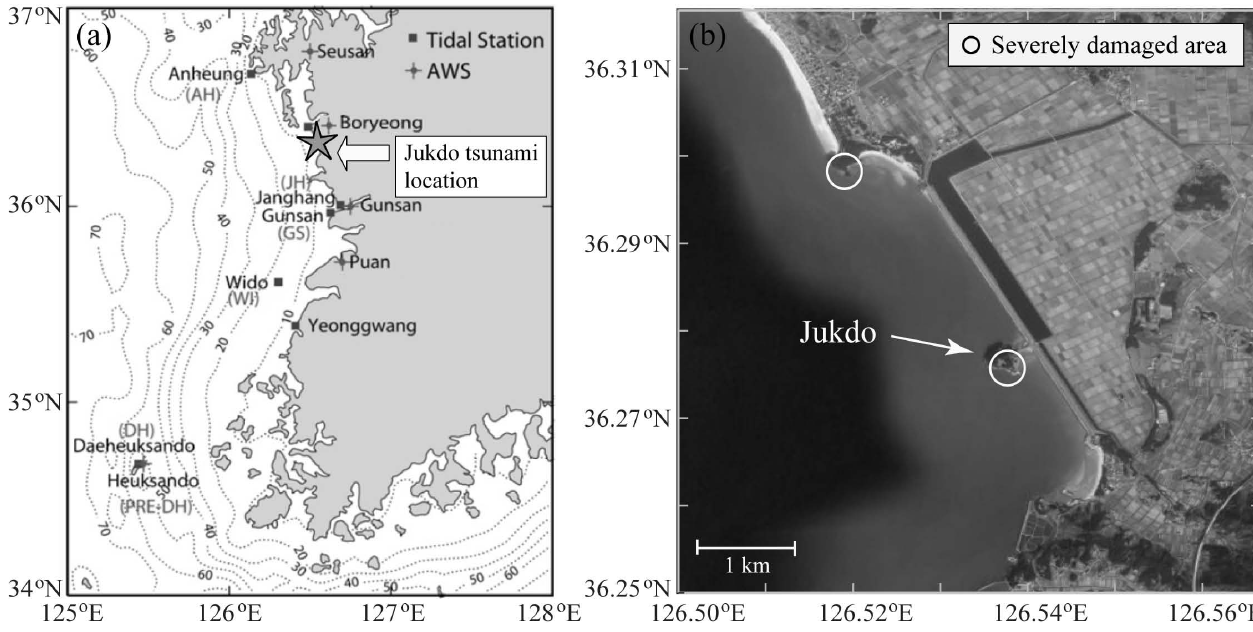
Fig. 1. (a) Location of the abnormal large and long waves observed on the west coast of Korea (i.e. Jukdo coastal pocket beach) on 4 May 2008 with marks of Tidal Stations (square) and Automated Weather Station (AWS) (plus), (b) and with indication of severely damaged areas and losses of life.